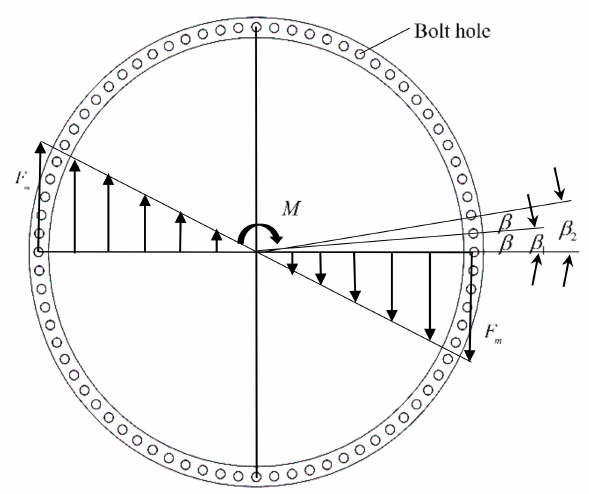
Figure 1. The stress distribution of the main shaft-to-hub bolted